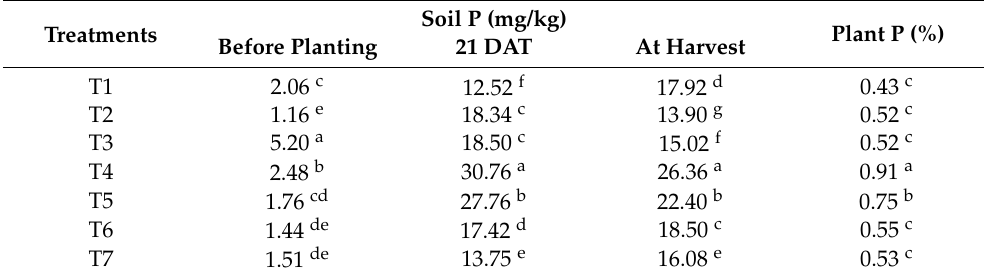
Table 4. Effect of chemical, organic, and biofertilizer treatments on soil and plant phosphorus